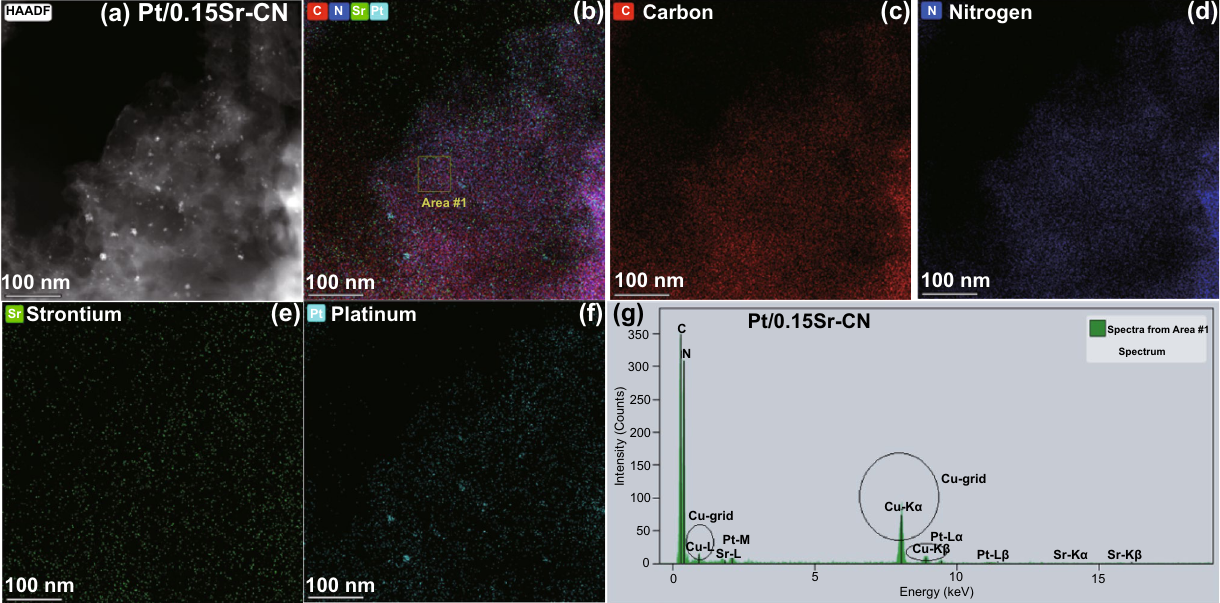
Fig. 3 TEM mappings of a, b Au/0.15Sr-CN, c carbon element, d N element, e Strontium element, and f Gold. g EDX spectrum of Au/0.15Sr- CN sample